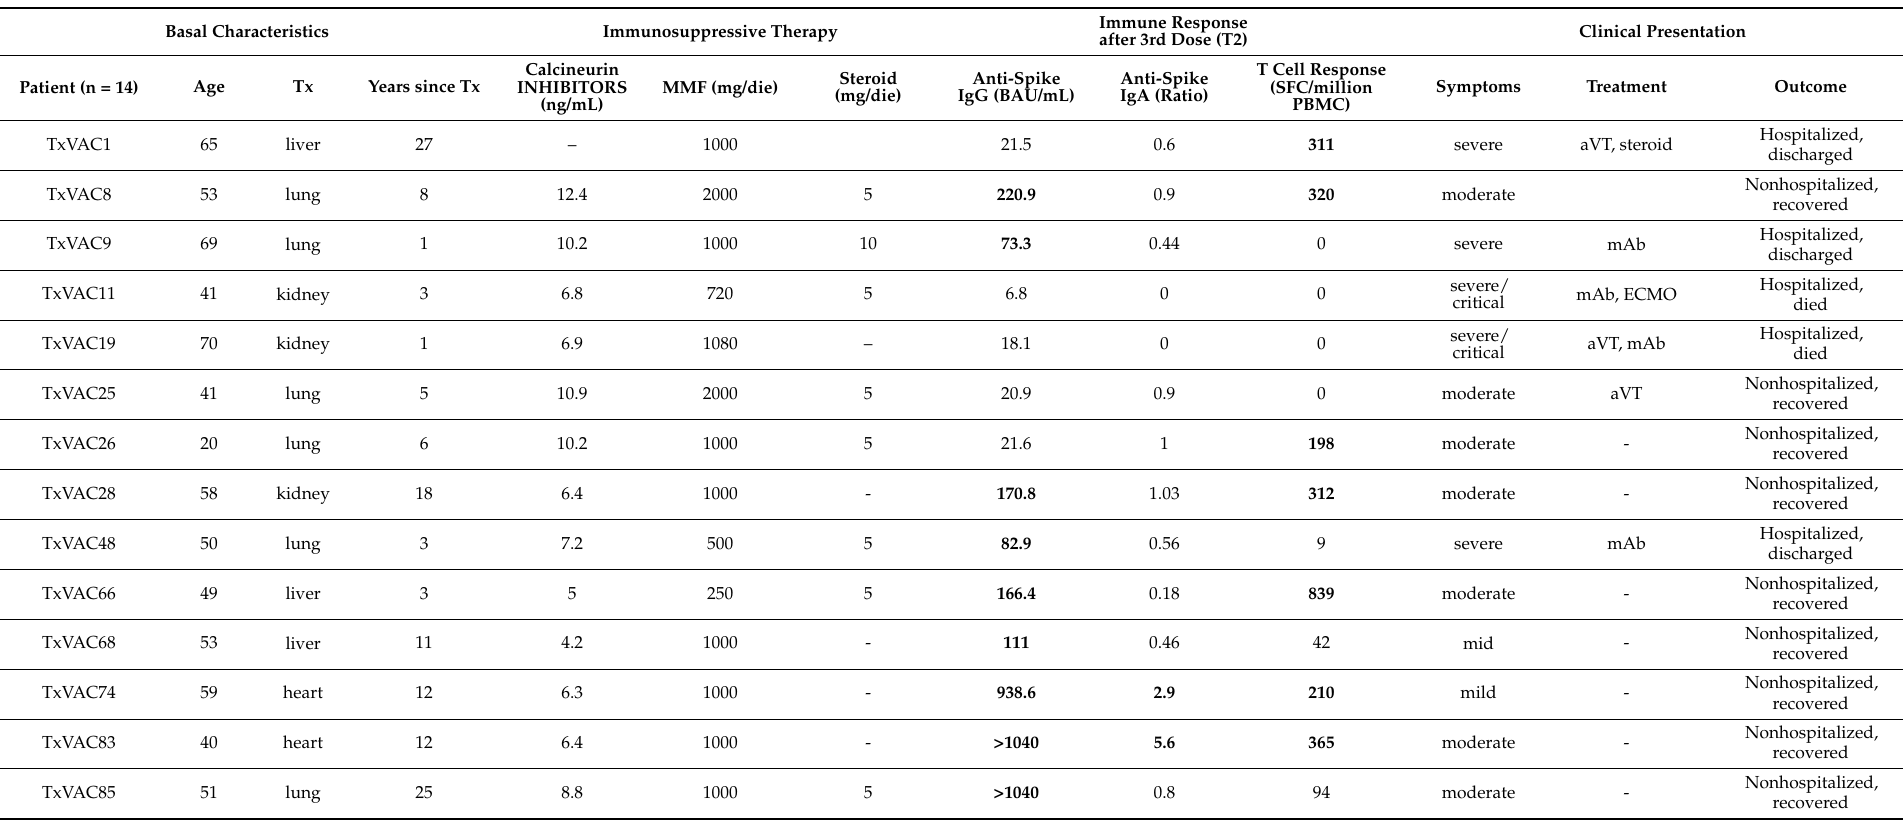
Table 2. Baseline characteristics, humoral and cellular immune response and COVID-19 outcome in 14 SOTRs. SOTRs with a positive humoral or cellular immune response are highlighted in bold. Abbreviations: TX: transplant; MMF: Mycophenolate-mofetil; aVT: antiviral therapy; mAb: monoclonal